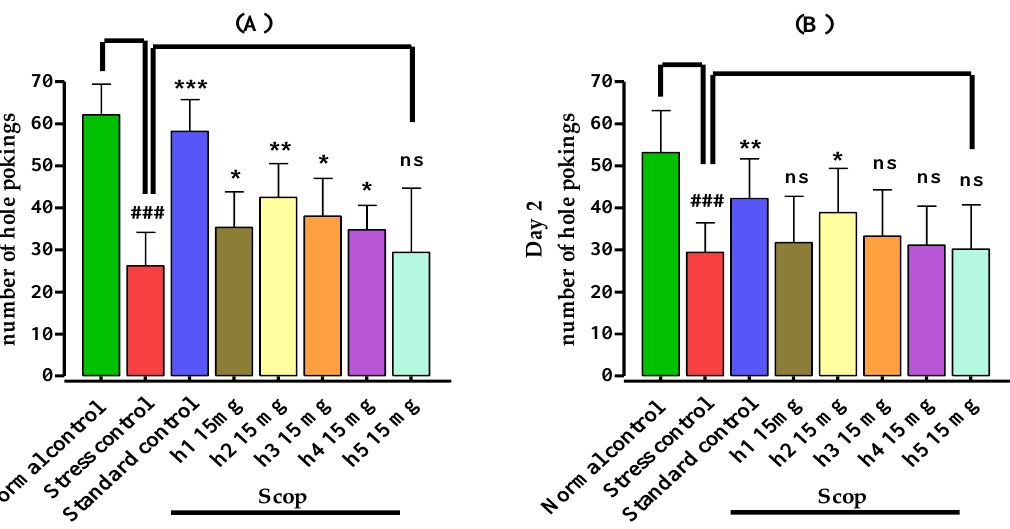
Figure 3. Effect of mono-carbonyl curcumin analogues ( h1 – h5 ) on ( A ) no. of hole pokings on day 1 and ( B ) no. of hole pokings on day 2. Results are shown as mean ± SD, n = 8. Kolmogorov–Smirnov test was applied for normality distribution and each data set was found to have a normal distribution. One-way ANOVA, followed by Bonferroni’s multiple comparison tests (post hoc), was applied on each data set and expressed as ### p < 0.001 vs. normal control group, and *** p < 0.001, ** p < 0.01, * p < 0.05, “ ns ” p ˃ 0.05 vs. stress control group.